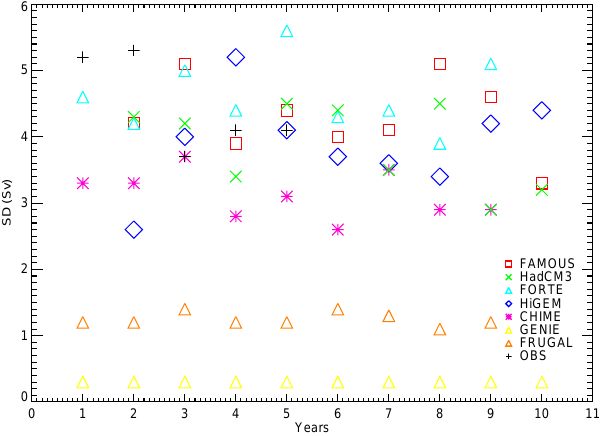
Fig. 3. Standard deviation of the 5-daily Atlantic MOC ( T over ) at Figure 3: Standard deviation of the 5-daily Atlantic MOC ( T over ) at 26 o N for each year of 26 ◦ N for each year of simulations and observations. (Since the ob- simulations and observations. (Since the observational timeseries starts in April, the SD is calculated from April to March and some models are missing a year because of wanting to servational timeseries starts in April, the SD is calculated from April start all the years in April.) to March and some models are missing a year because of wanting to start all the years in April.)